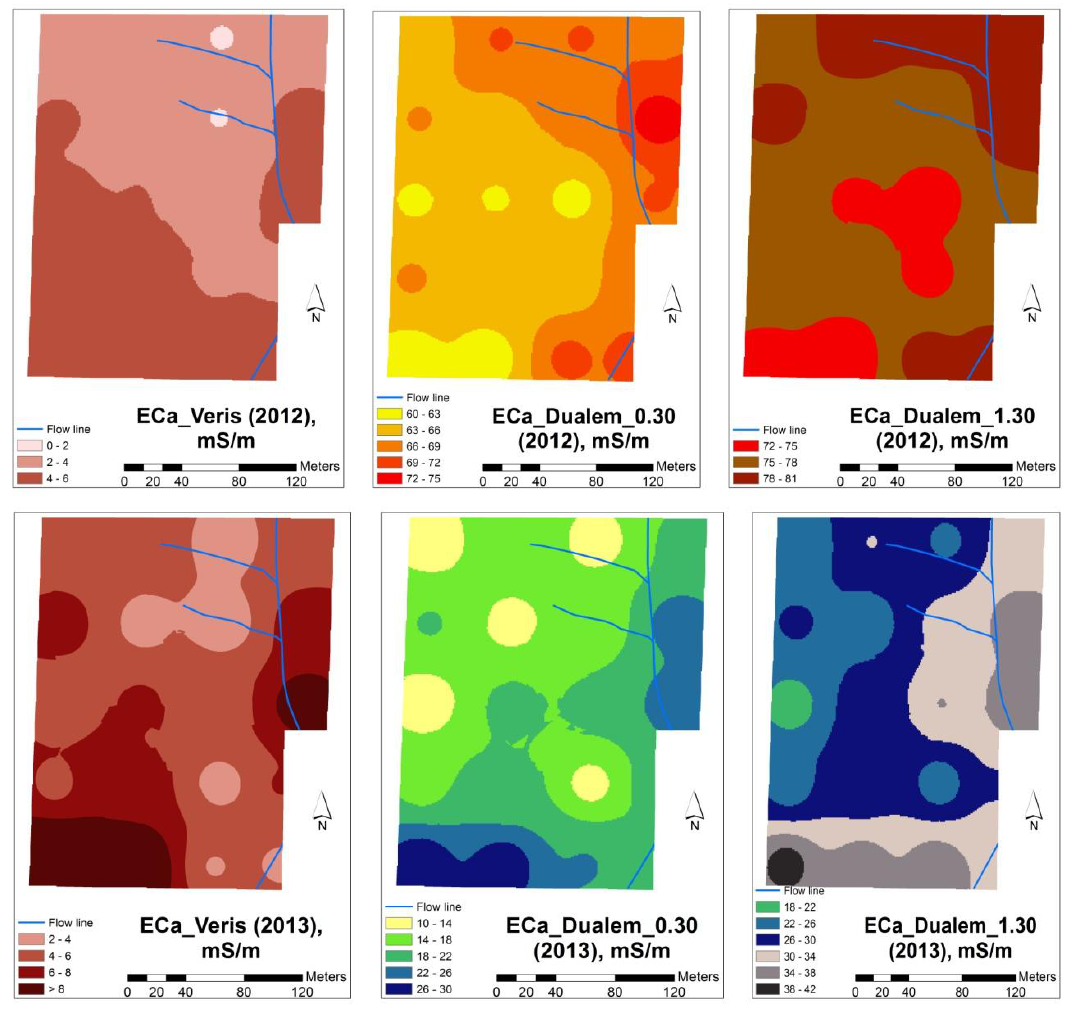
Figure 7. Apparent soil electrical conductivity measured by Veris and DUALEM sensors in the experimental field in February of 2012 ( top ) and February of 2013 ( bottom